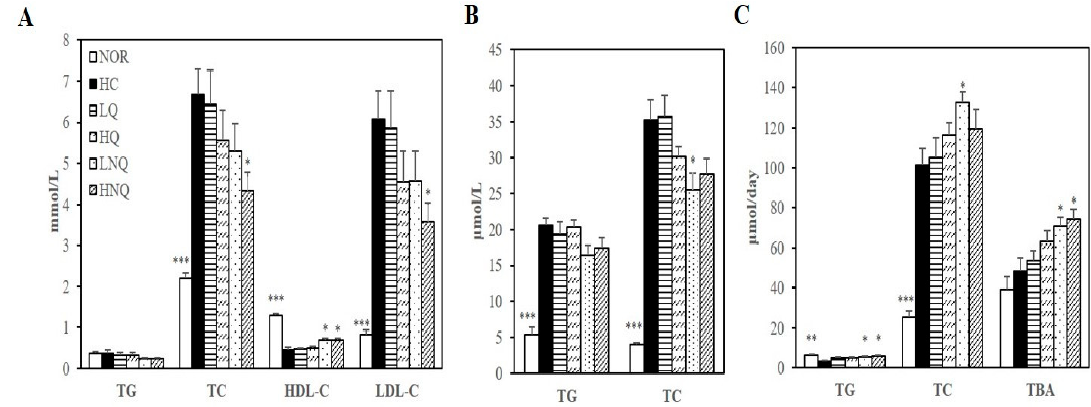
Figure 3. Effects of nanoemulsion quercetin on serum, hepatic and fecal lipid profiles. ( A ) Serum lipid profiles. LDL-C = TC − HDL-C − (TG/5). ( B ) Hepatic lipid profiles. ( C ) Fecal lipid profiles together with bile acid levels. Values are expressed as mean ± SEM ( n = 8). * p < 0.05, ** p < 0.01, *** p < 0.001